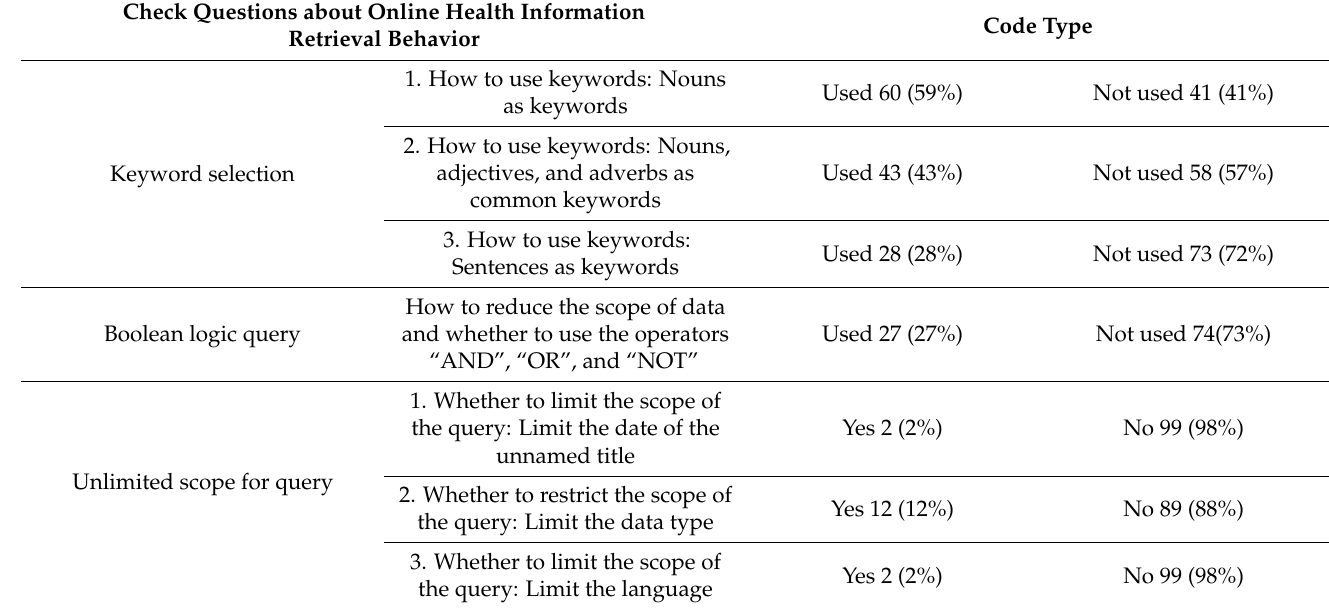
Table 2. Current status of health information retrieval behavior among undergraduate students: Information seeking. Check Questions about Online Health Information Retrieval